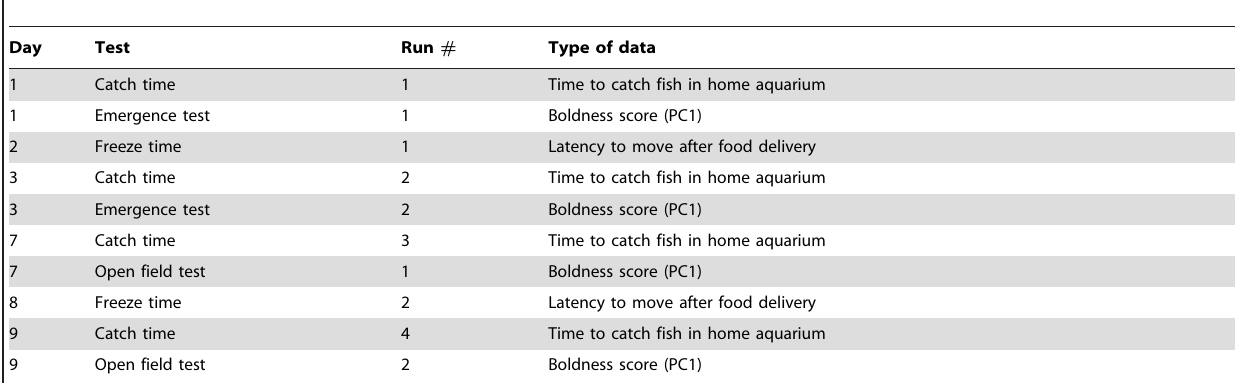
Table 1. Order and timing of tests and behaviour data used in subsequent analyses of boldness in two-spotted goby males after 48 h of acclimatisation in their home aquarium.